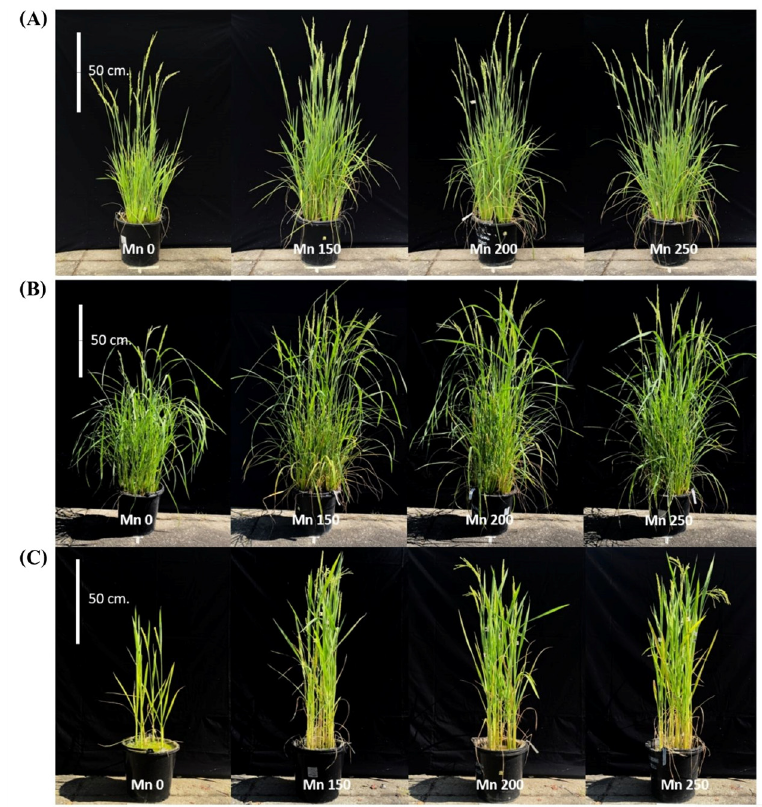
Figure 7. Rice plants at the flowering stage of three fragrant rice varieties (BNM4 ( A ), KDML105 ( B ) and KH-CMU ( C )) grown under four manganese concentrations. Photographs were taken 69, 80 and 57 days after germination of BNM4, KDML105 and KH-CMU,